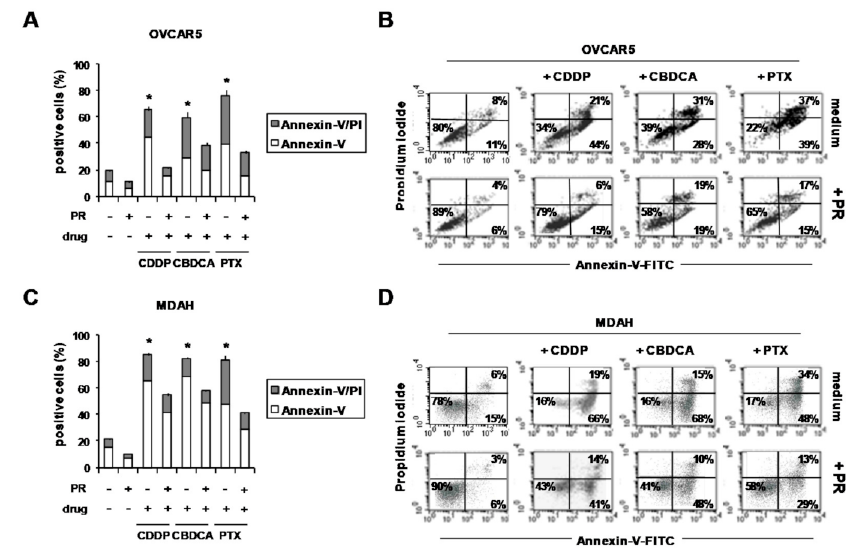
Figure 4. PR reduced the pro-apoptotic effects of CDDP, CBDCA and PTX in PR-OvCa spheroids. OVCAR5 and MDAH cells were cultured for 5 days with PR (10%) in poly-HEMA-coated wells to form spheroids. Then, cells were treated with CDDP, CBDCA and PTX. After 72 h, OvCa spheroids were dissociated into single-cell suspensions by means of trypsinization and stained with Annexin-V- FITC and PI. ( A , C ) Histograms showing the percentage of Annexin-V- and Annexin-V/PI-positive cells ( B , D ) Representative flow cytometric dot-plots showing the percentage of Annexin-V-, Annexin- V/PI- and PI-positive cells. * p < 0.01 (untreated vs. PR-treated cells).